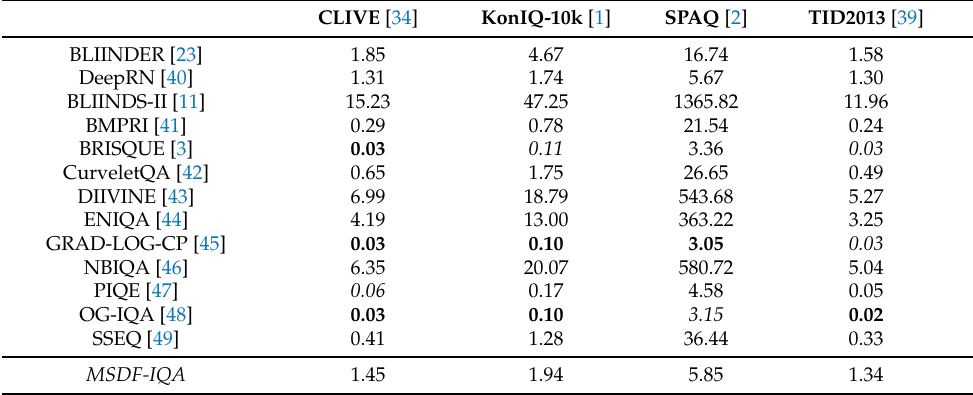
Table 12. The best results are typed in bold , and the second best ones typed in italic